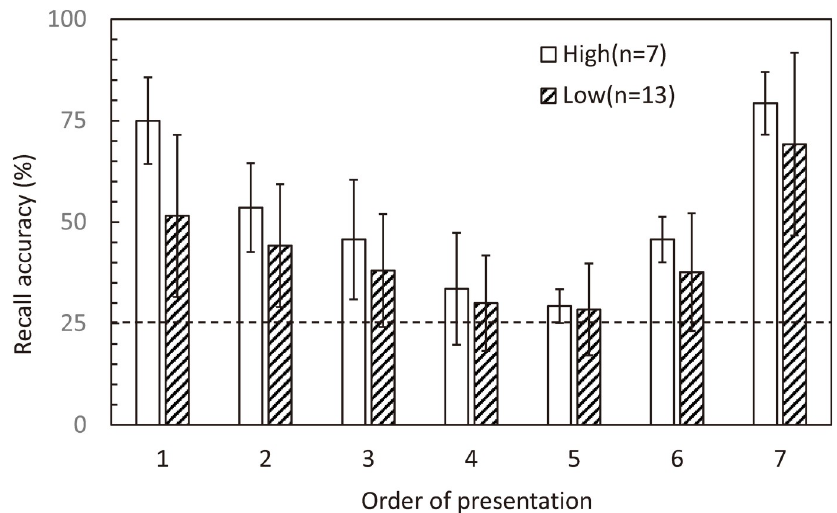
Fig 2. Recall accuracies against the order of presentation in the memory sequence. Recall accuracy is high for numerals corresponding to arrows in the beginning (first and second) and end (sixth and seventh) sub-periods, while low for those corresponding to the middle (third–fifth) sub-period. Recall accuracy appears visibly different between High and Low MoCA scoring groups. See the statistical results in Fig 3. Error bar: S.D.